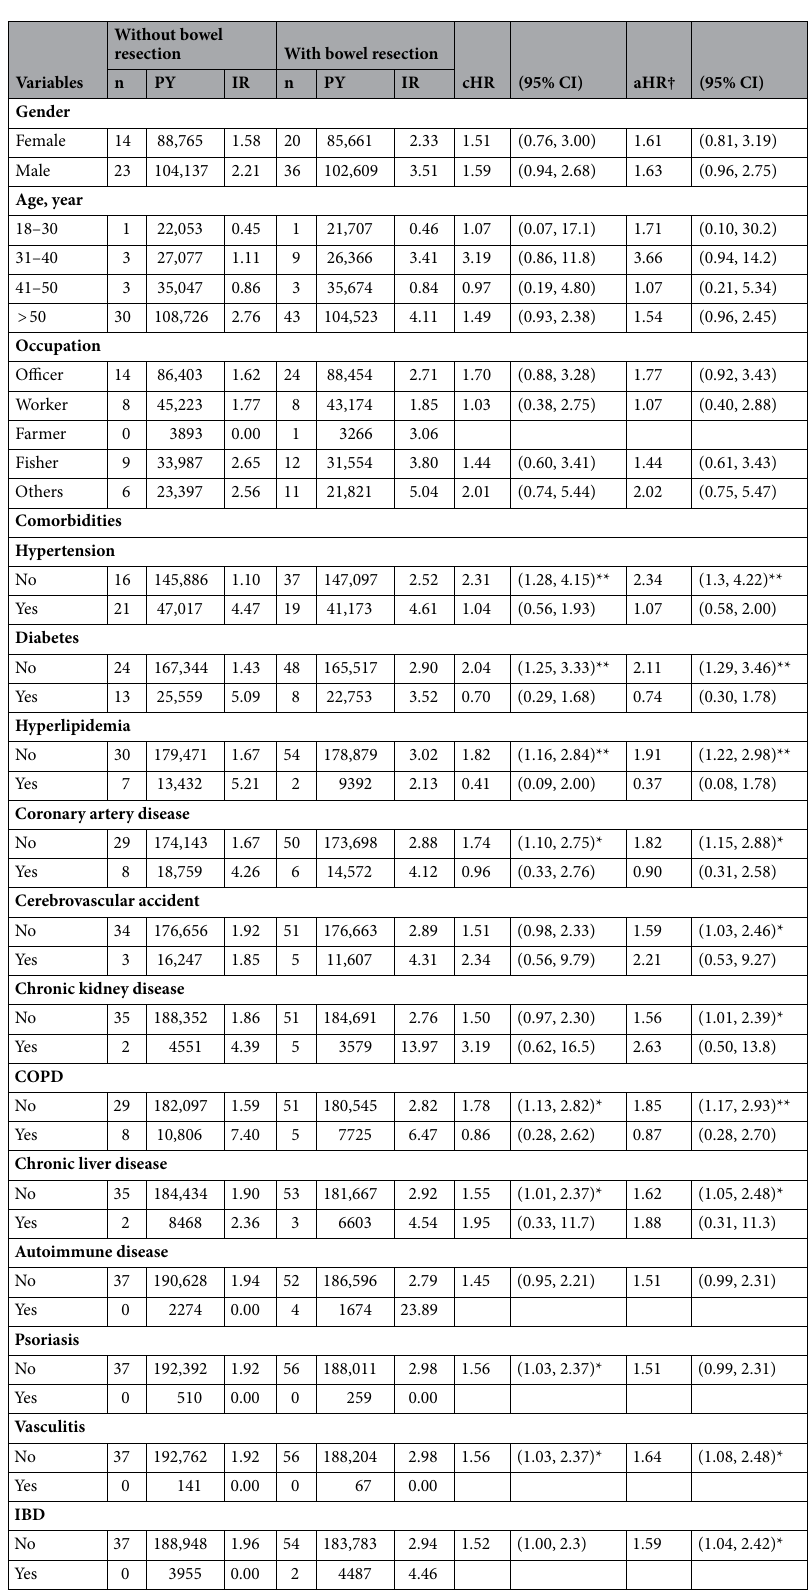
Table 3. The Stratification Analysis of NTS Infection. NTS nontyphoidal salmonella, COPD chronic obstructive pulmonary disease, IBD inflammatory bowel disease, PY person-year, IR incidence rate per